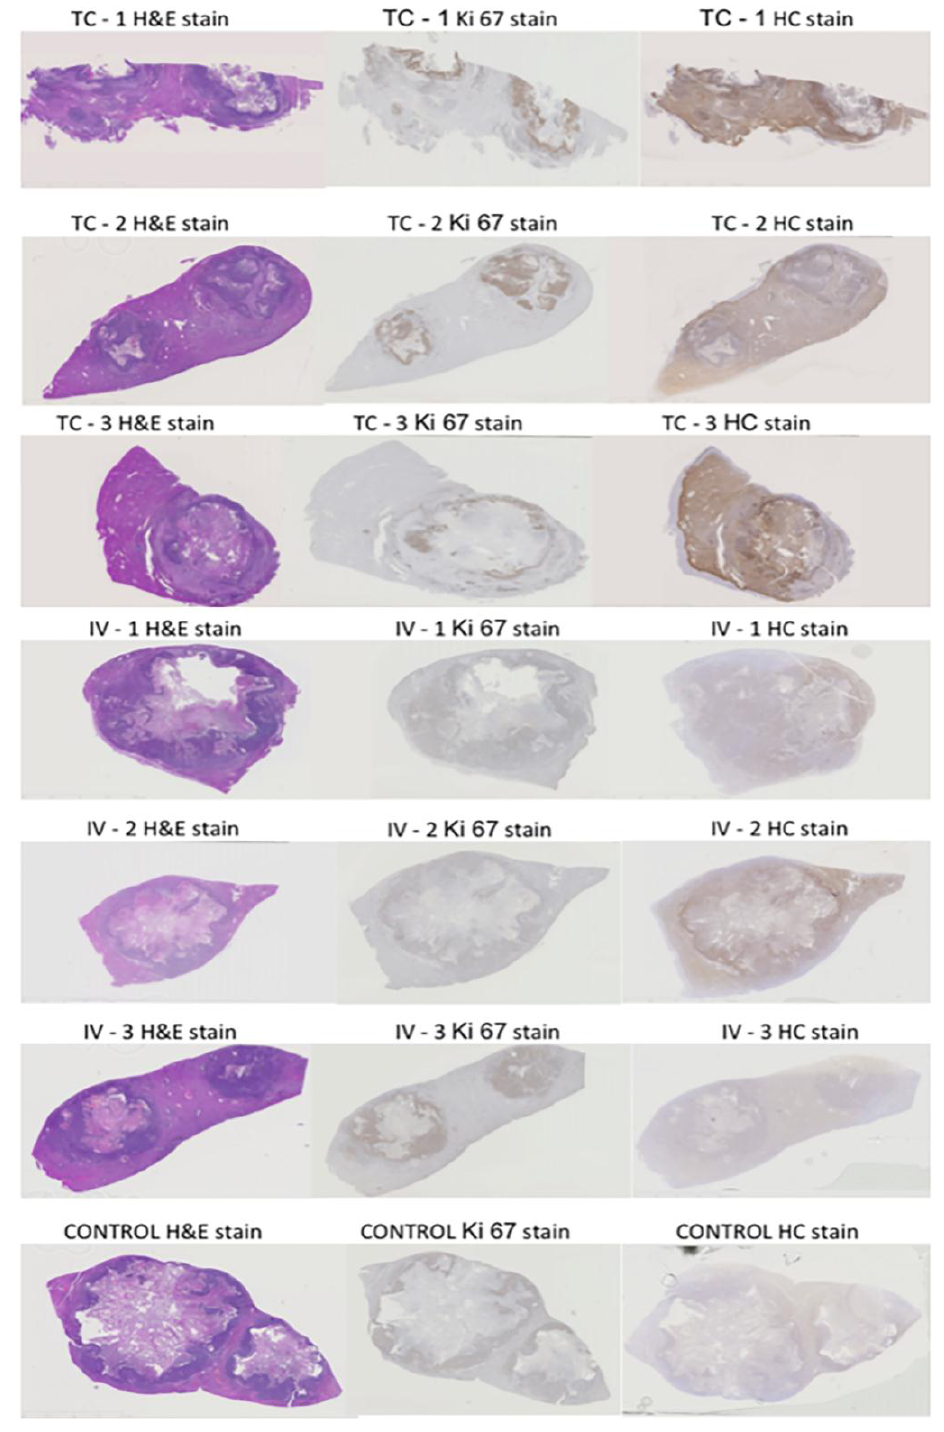
Figure 1. Intravenous (IV) and transarterial intra-catheter (IC) injected rabbits’ VX2 tumors and surrounding liver tissue stained by H&E, histochemical (HC) stain (detecting the nanoparticles) and Ki67 Antibodies.